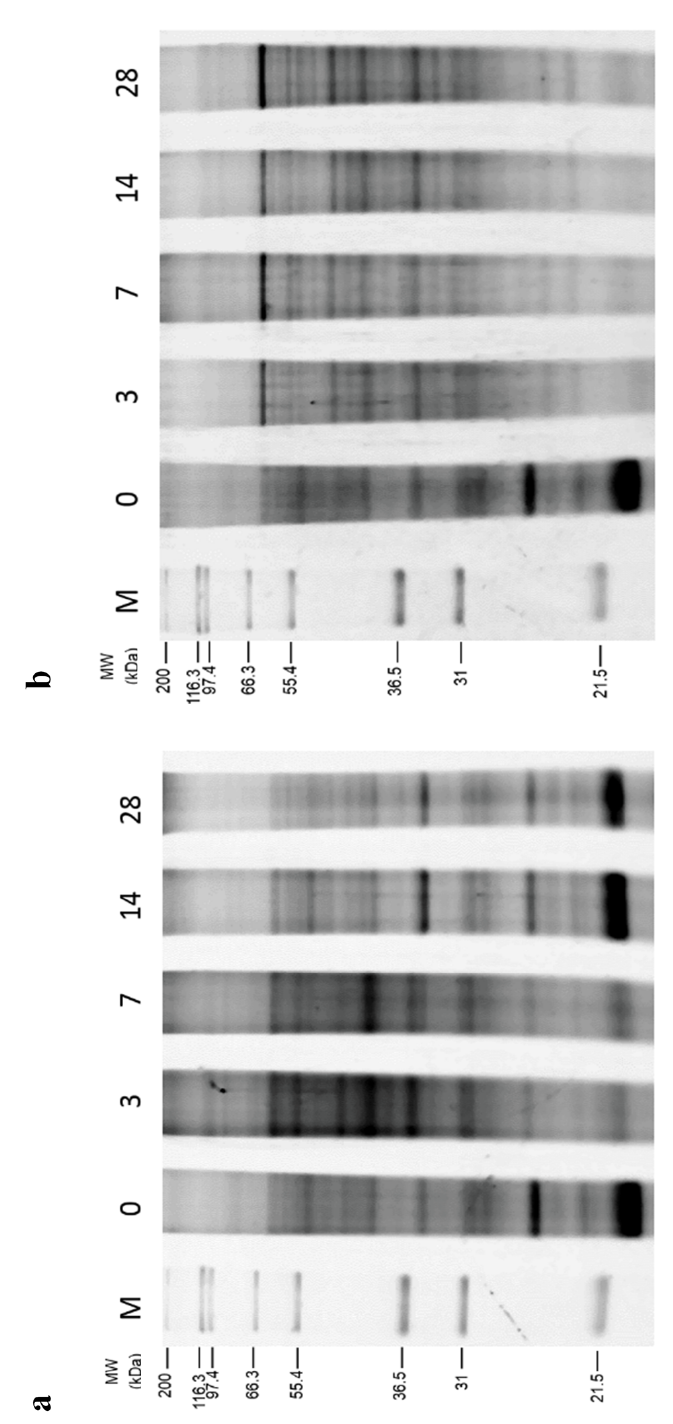
Figure 3. Breviolum protein expression for ( a ) MeOH and ( b ) PG treatment groups by the 3rd, 7th, 14th and 28th day of culture after thawing. The horizontal axis shows different days of culture, with M representing the marker and 0 representing Breviolum protein expression of untreated control group. The vertical axis indicates molecular